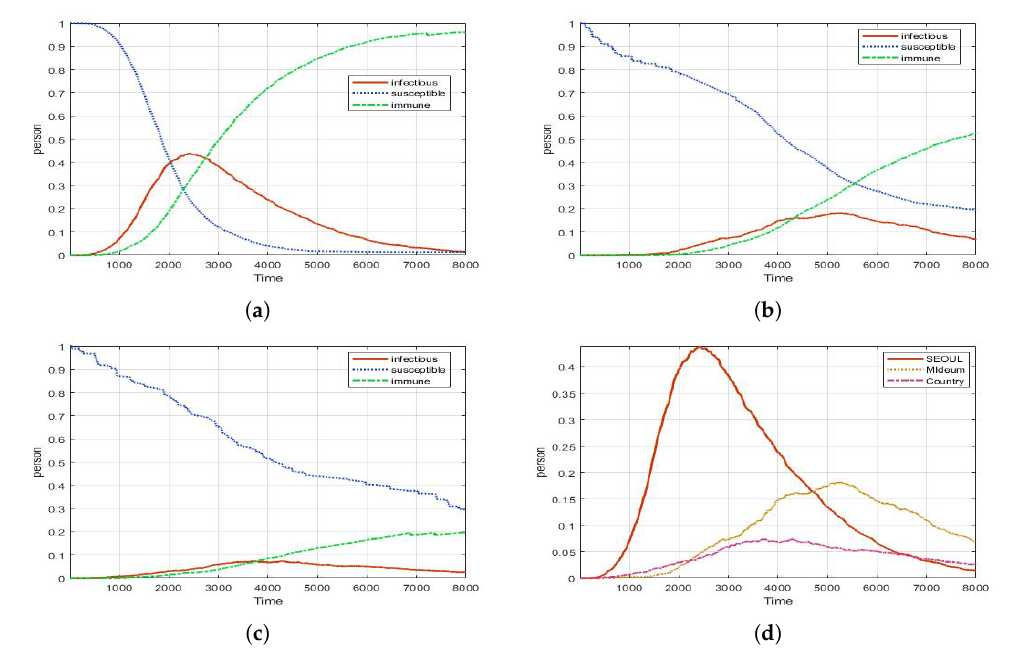
Figure 7. Experimental results for Social-distance (with different density of population): ( a ) Seoul (peak: 0.43, 2416 ticks); ( b ) Metro city (peak: 0.18, 5237 ticks); ( c ) Country (peak: 0.07, 3596 ticks); ( d ) Infectious for all areas.